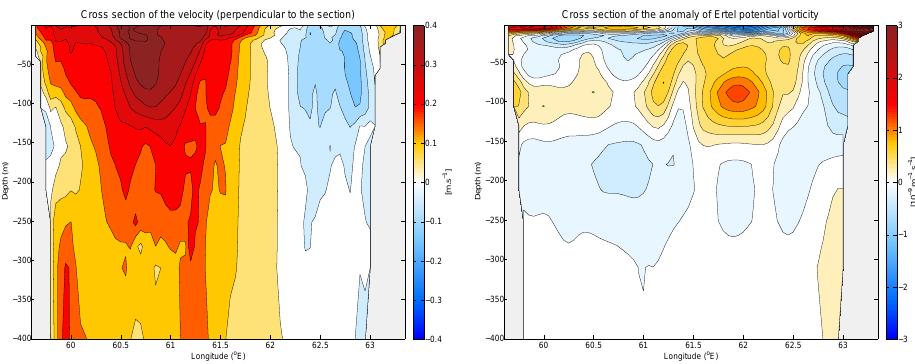
Figure 9. Section across the eddies during the winter monsoon (from HYCOM): (left) velocities across the section (positive toward the southeast); (right) anomaly of Ertel potential vorticity. The core of the eddies is intensified in the first